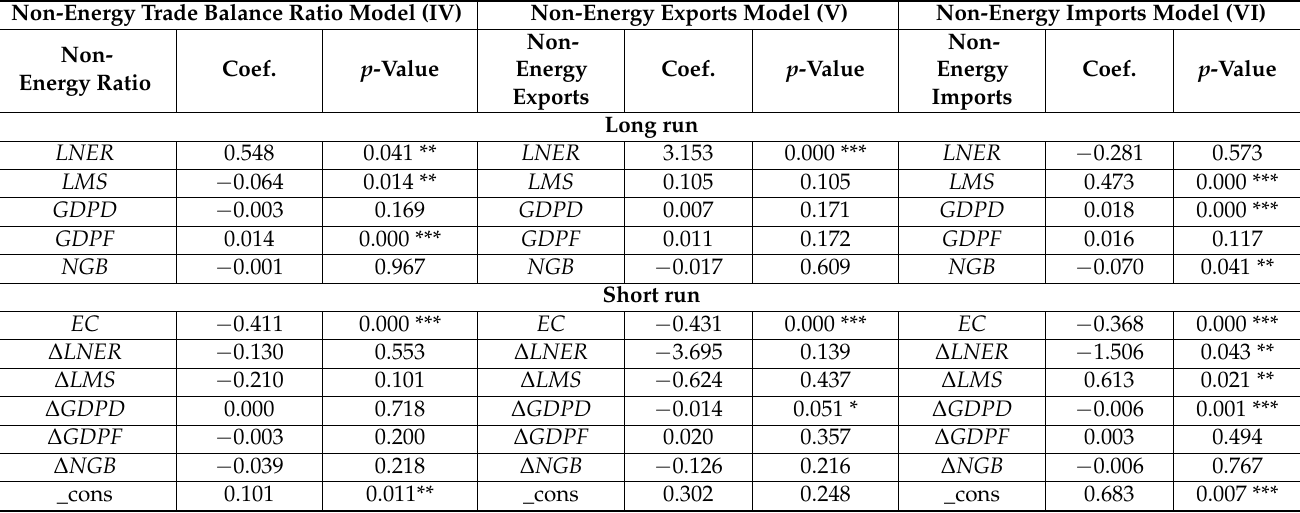
Table 3. The determinants of T&T’s non-energy trade (manufacturing and agriculture) 1991–2019 using PMG